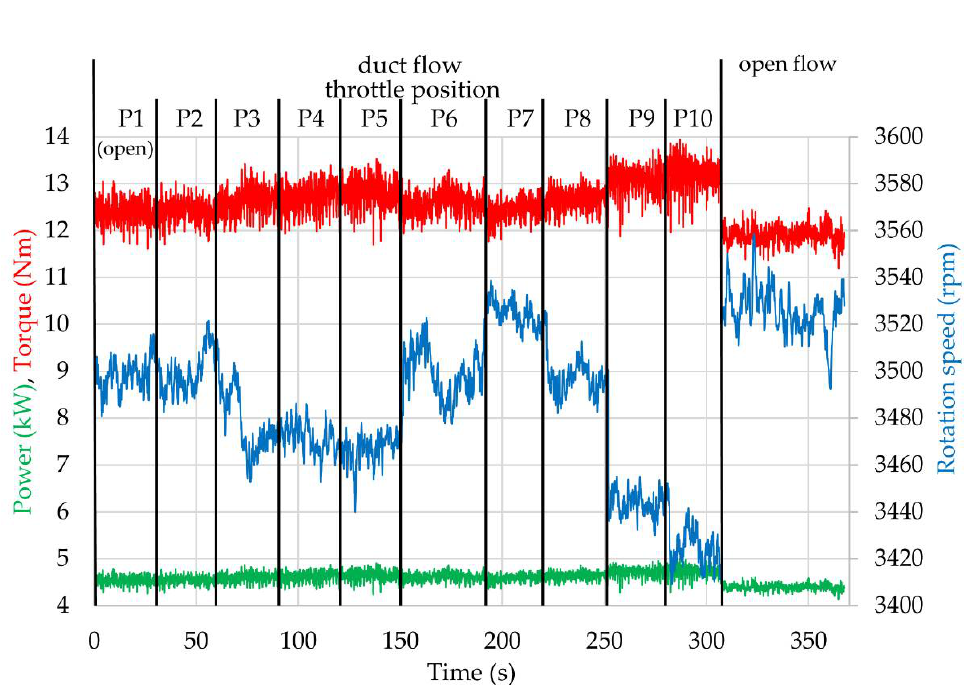
Figure 5. Power, torque, and speed during tests of fan W1 using Method A (duct flow) with variable damper closure and Method B (open flow).